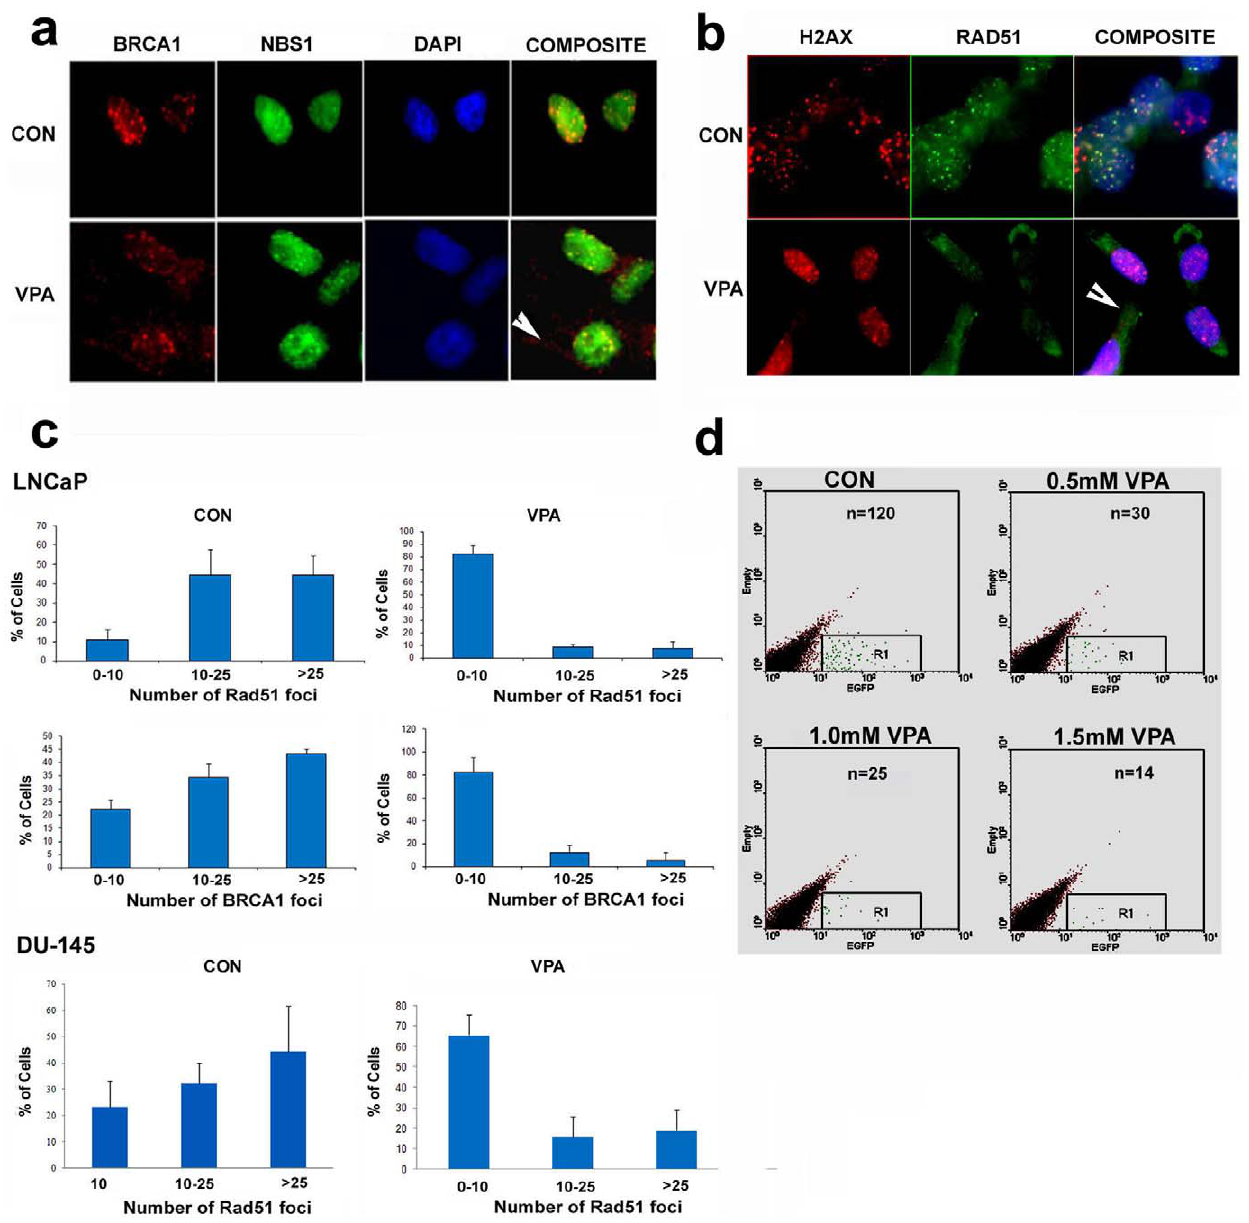
Figure 6. Recruitment of HR repair proteins to the damaged site and HR repair in VPA treated PCa cells. a) Immunofluorescence analysis of DU-145 cells treated with 1.5 mM VPA for 48 h and irradiated with 4Gy of radiation probed for BRCA1 (red) and NBS1 (green). Nuclei were counterstained with DAPI. Cytoplasmic BRCA1 (arrow) seen in VPA treated cells suggest impaired recruitment of BRCA1 in VPA treated cells. b) Immunofluorescence analysis of LNCaP cells treated with 1.5 mM VPA for 48 h and irradiated with 4Gy of radiation probed for H2AX Ser 139 (red) and RAD51 (green). Nuclei were counterstained with DAPI. Cells having . 25 H2AX Ser 139 foci were analyzed. Cytoplasmic RAD51 (arrow) seen in VPA treated cells suggest impaired recruitment of BRCA1 in VPA treated cells. c) Quantification of the number of BRCA1 and RAD51 foci colocalizing with H2AX Ser 139 foci in DU-145 and LNCaP cells after treatment with 1.5 mM VPA and irradiation with 4Gy of radiation. A total of 100 cells having . 25 H2AX Ser 139 foci were counted. Error bars indicate standard deviation from mean. d) FACS analysis depicting a HR repair assay using a plasmid reporter construct in LNCaP cells after treatment with varying concentration of VPA.